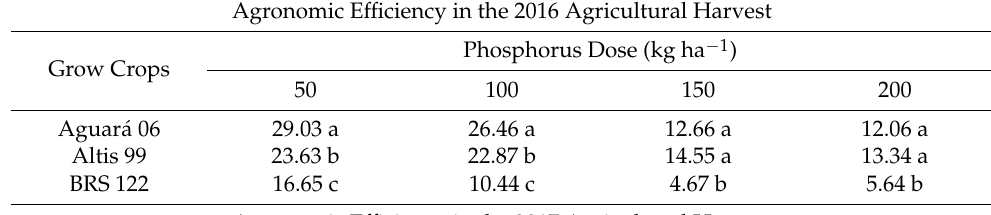
Table 1. Average values for agronomic efficiency as a function of sunflower cultivars within phos- phorus doses in the 2016 and 2017 agricultural season.